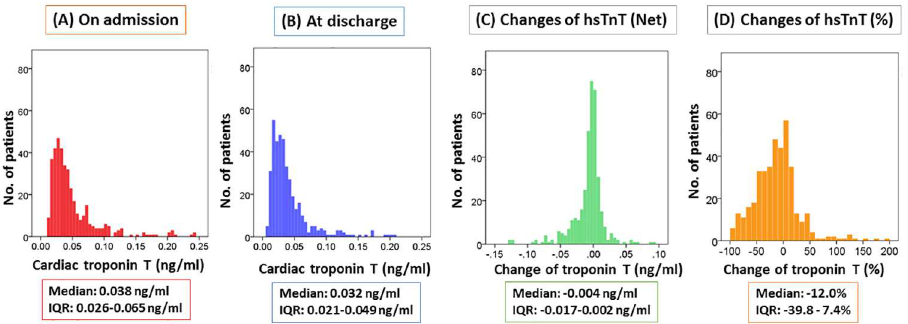
Fig 1. Distribution of hsTnT level on admission to the hospital (A), at discharge (B), changes in hsTnT levels (net) (C) and changes in hsTnT levels (percent) (D). The median(interquartileranges) high sensitive cardiactroponinT (hsTnT) levels on admission,at discharge, and changesin hsTnT levels (net) were 0.038 (0.026 to 0.065), 0.032 (0.021 to 0.049), and -0.004 (-0.017 to 0.002) ng/ml, respectively. The percent change of hsTnT was -12.0 (-39.8 to 7.4)